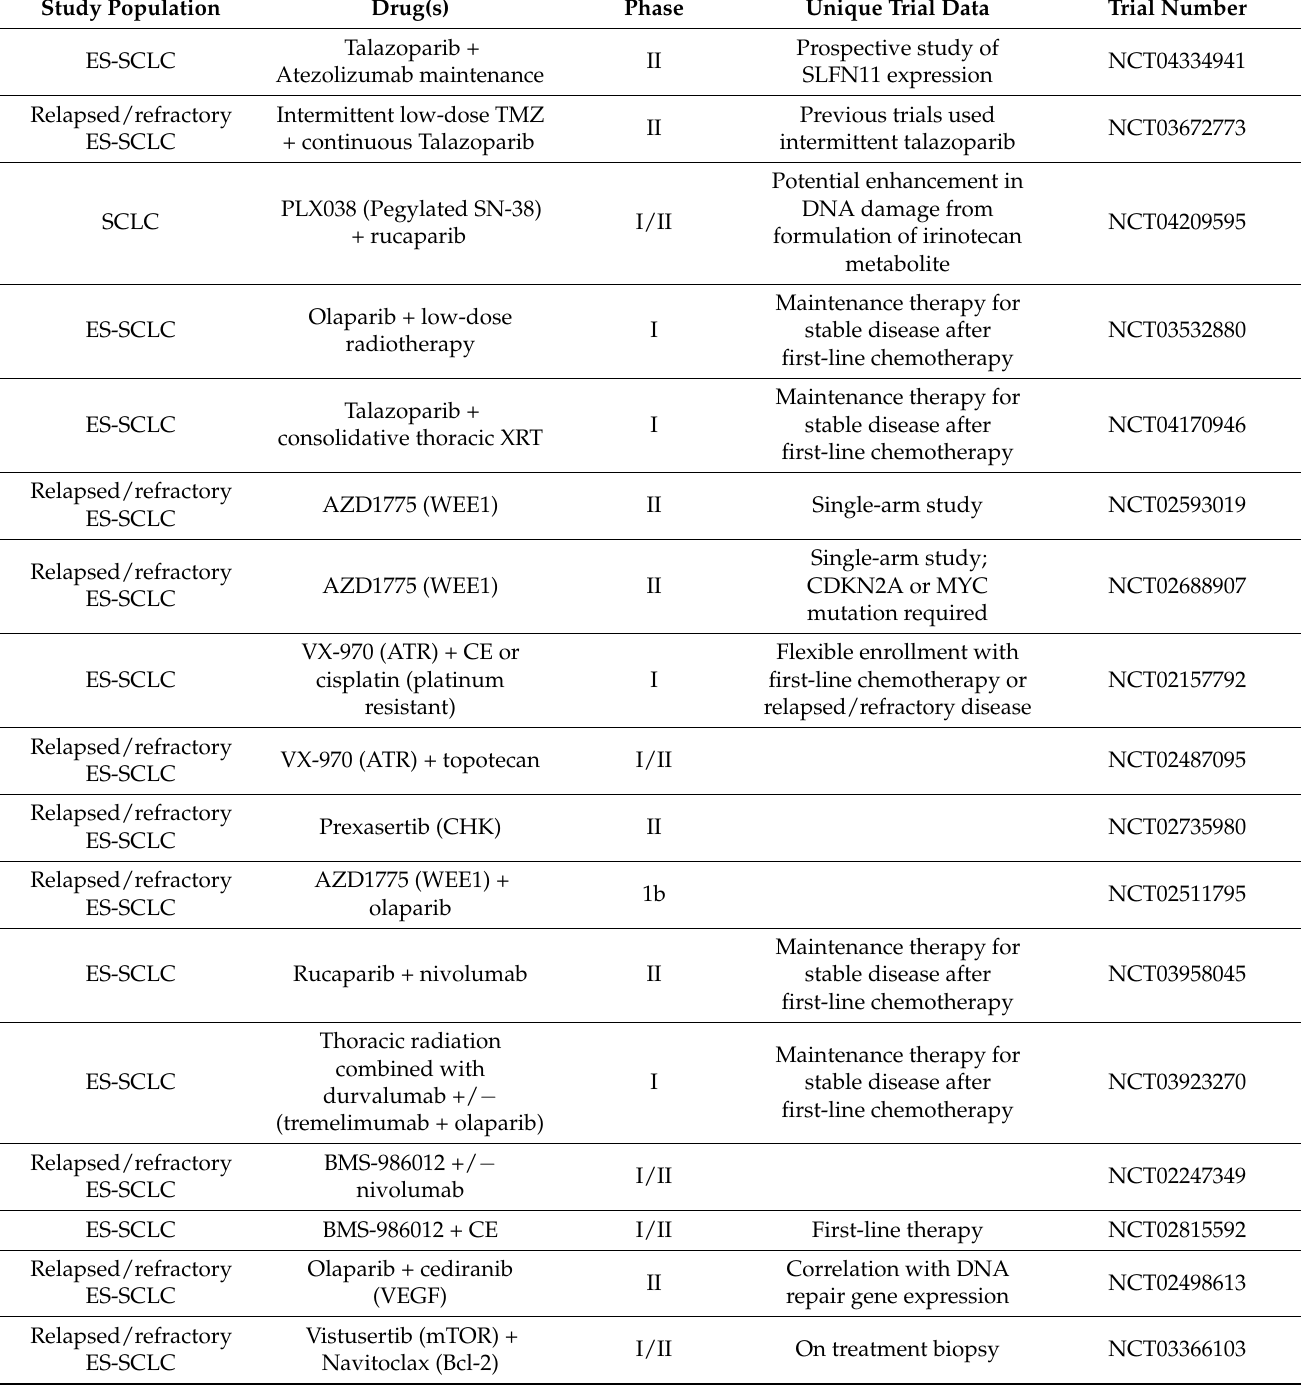
Table 2. Ongoing studies in